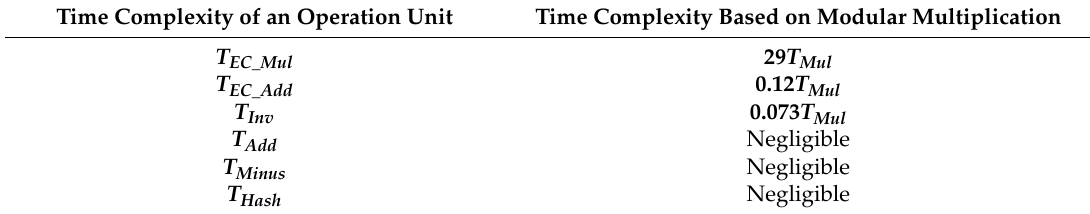
Table 1. Unit conversion of various operations based on modular multiplication.